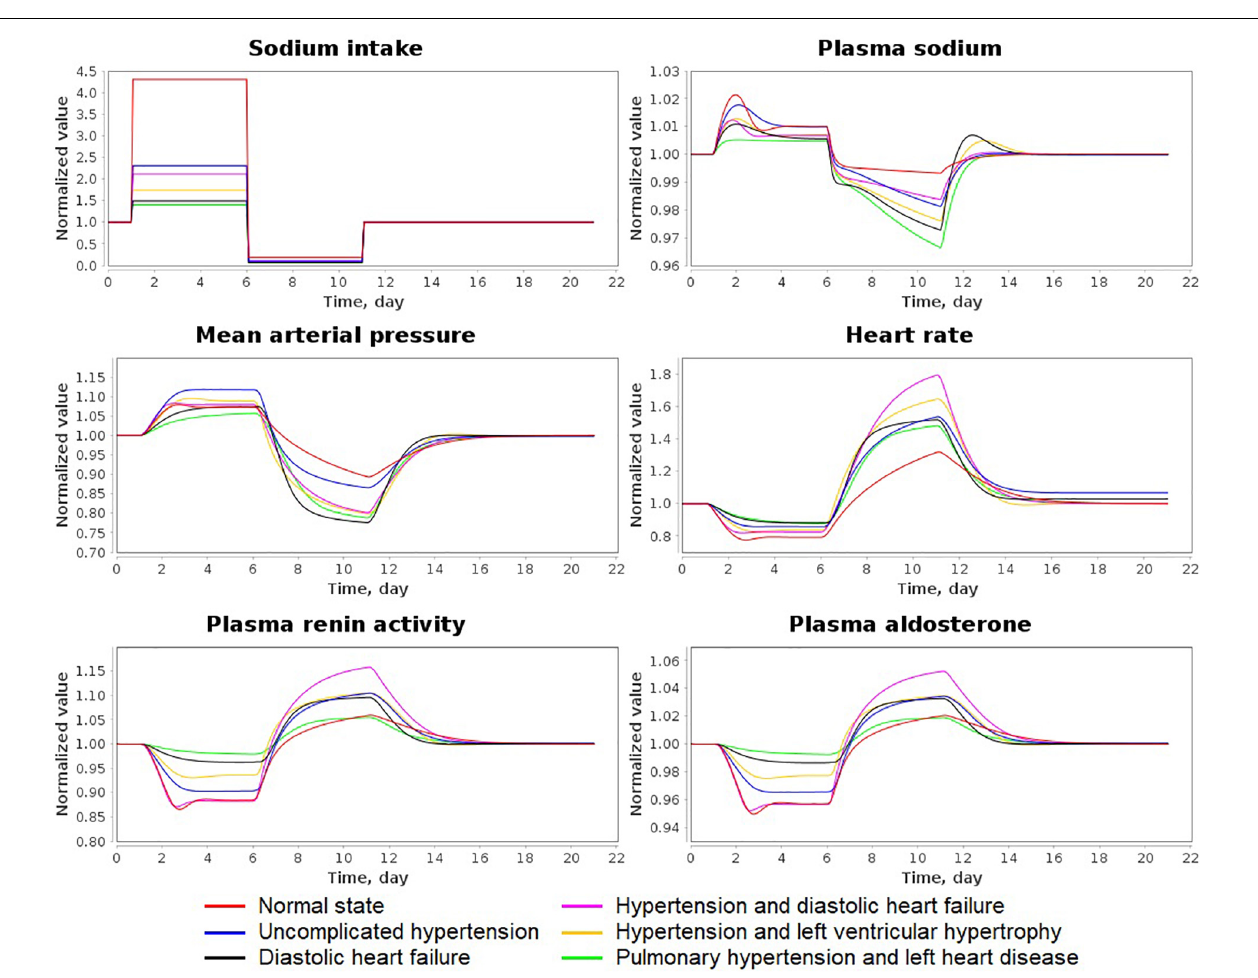
FIGURE 7 | Simulation results of the sodium load experiment for all states of the model. The simulation experiment was designed in accordance with experimental study by He et al. (2001) and involves a 5-day high sodium diet followed by a 5-day low sodium diet. Variable values are normalized to the initial equilibrium values declared in the